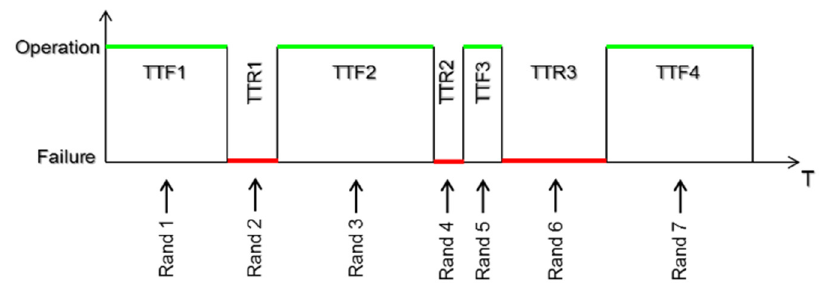
Figure 4. Method of failure history generation [80,81].